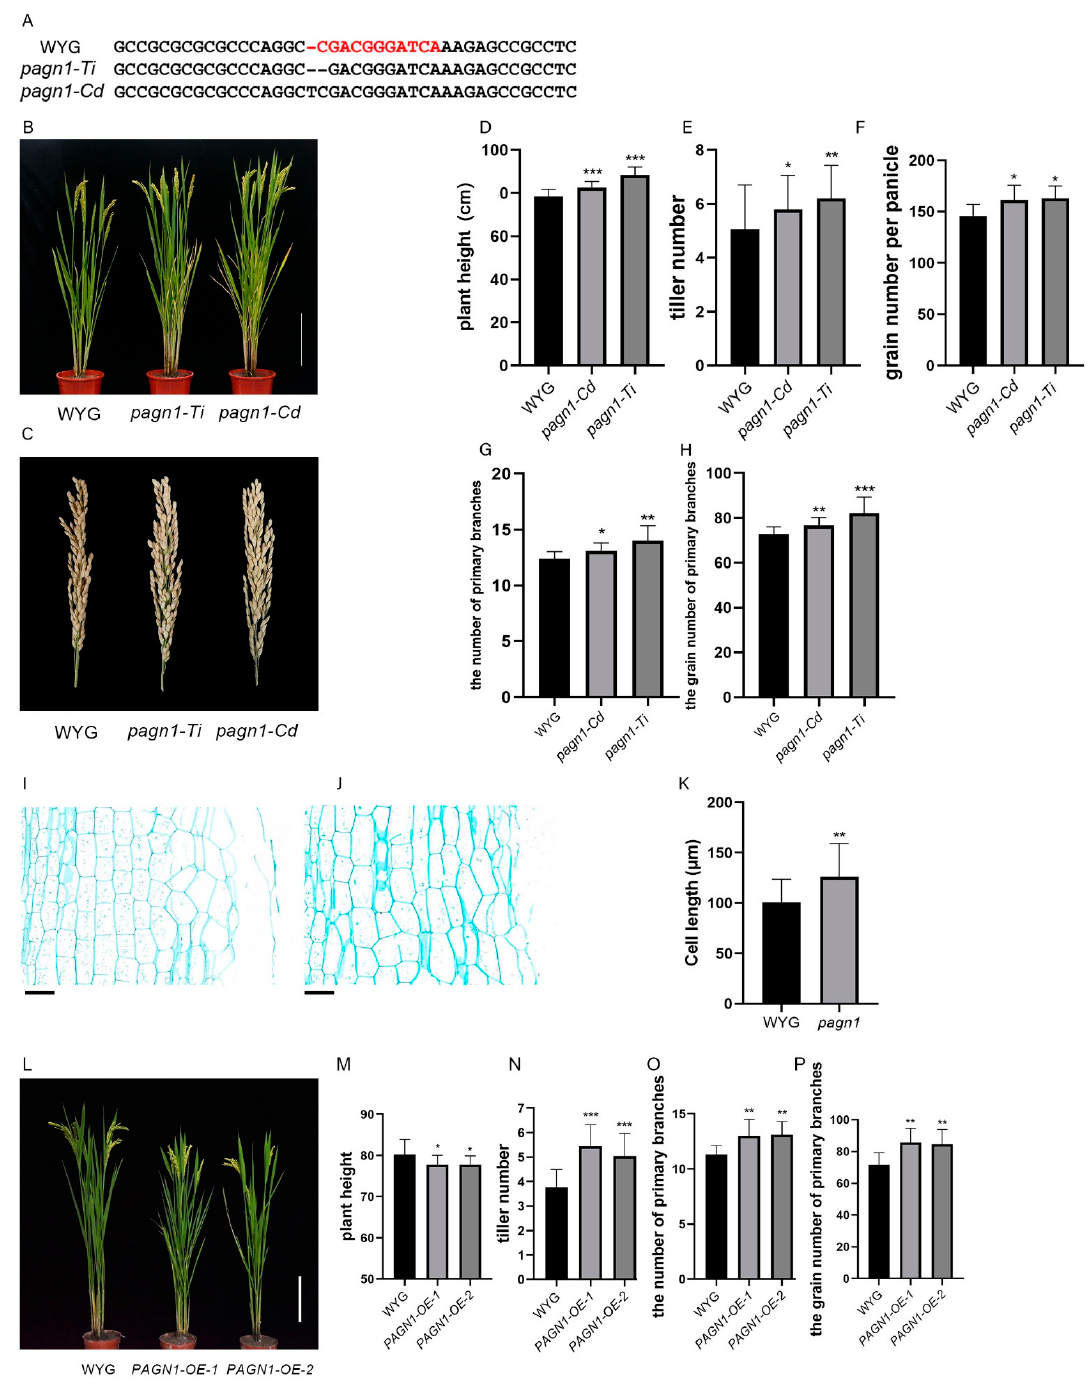
Figure 1. Phenotypes of OsPAGN1 transgenic lines. ( A ) Target site in the OsPAGN1 sequence in the OsPAGN1 knockout lines pagn1-Ti and pagn1-Cd . ( B ) Plant architecture and ( C ) the panicles of the wild-type (Wuyugeng) and OsPAGN1 knockout lines. ( D – H ) Plant height, tiller number, grain number per panicle, number of primary branches, and grain number for the primary branches of the wild-type and OsPAGN1 knockout lines. ( I – K ) Stem cell length of the wild-type and OsPAGN1 knockout lines. Bar = 100 µ m. ( L ) Plant architecture of the wild-type and OsPAGN1 -overexpressing lines. ( M – P ) Plant height, tiller number, number of primary branches, and grain number for the primary branches of the wild-type and OsPAGN1 -overexpressing lines. The data are the mean ± SEM. * p < 0.05, ** p < 0.01, *** p < 0.001. (Student’s t